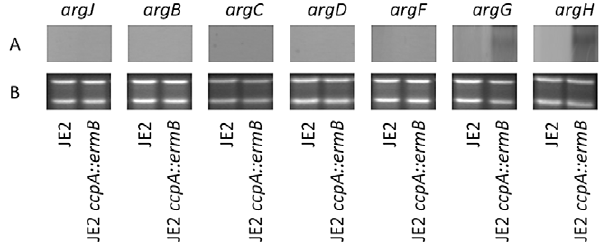
Figure 4. Northern analysis of arginine biosynthetic pathway in S.aureus JE2 and JE2 ccpA::ermB . JE2 and JE2 ccpA::ermB total RNA was isolated in mid-exponential phase of growth in CDM and CDM-R, respectively. DNA probes specific for argJ , argB , argC , argD , argF , argG , and argH were labeled with digoxygenin and detected using anti- digoxigenin-AP Fab fragments (Panel A). Panel B shows 16 s and 23 s rRNA depicting equal RNA